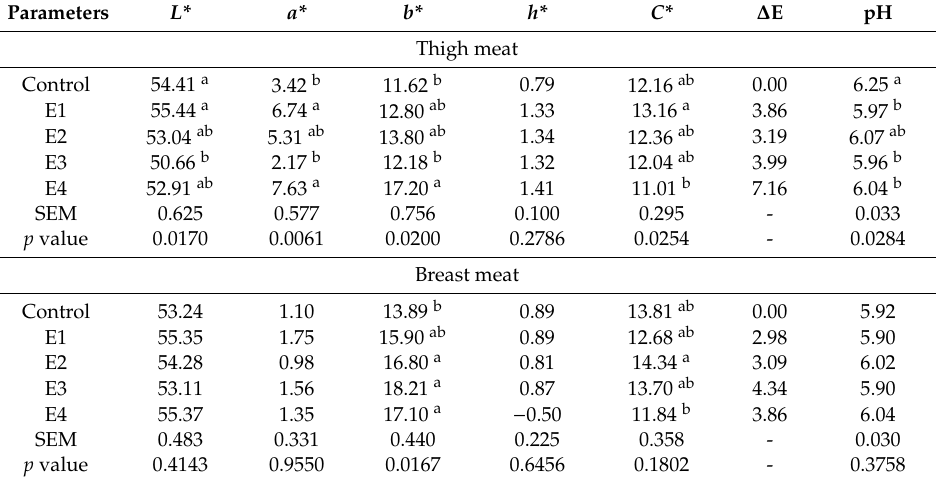
Table 3. Color parameters and the pH of the chicken